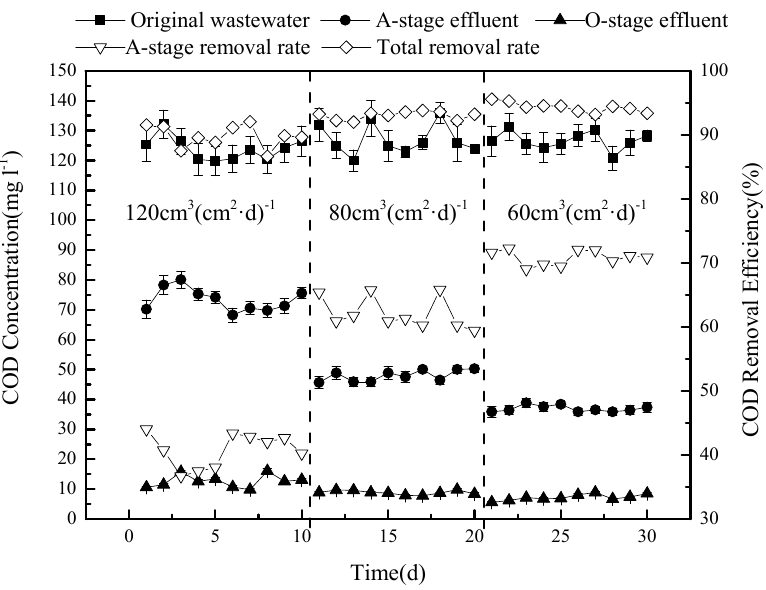
Figure 6. Variation in COD concentration ( top ) and COD removal efficiency ( bottom ) under three different hydraulic loads, with a decreased flow over time (120, 80 and 60 cm 3 (cm 2 · d) − 1 ) and a constant circulation